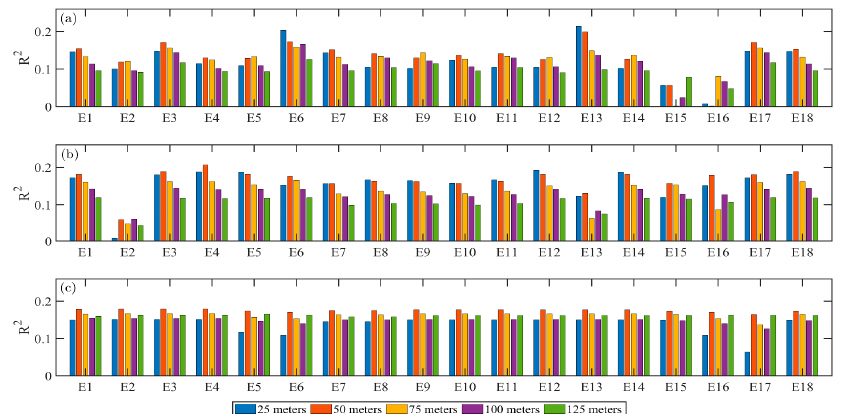
Figure 2. Histogram of coefficient of determination ( R 2 ) between index and chlorophyll contents using E1–18 (Table 1) using, ( a ) RGB color space with background; ( b ) RGB color space with only green pixels; ( c ) HSV color space with only green pixels.